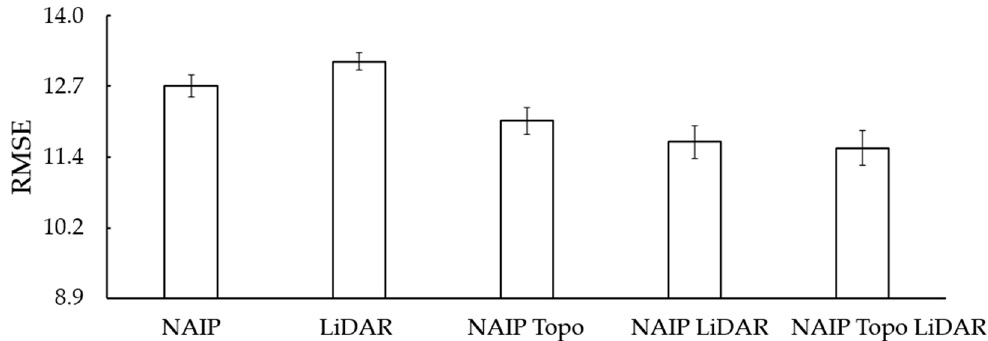
Figure 9. Variation in out of bag root mean squared error (RMSE) for 10 basal area weighted diameter Random Forest models. Results for quadratic mean diameter, basal area per hectare, and trees per hectare are given in Figure